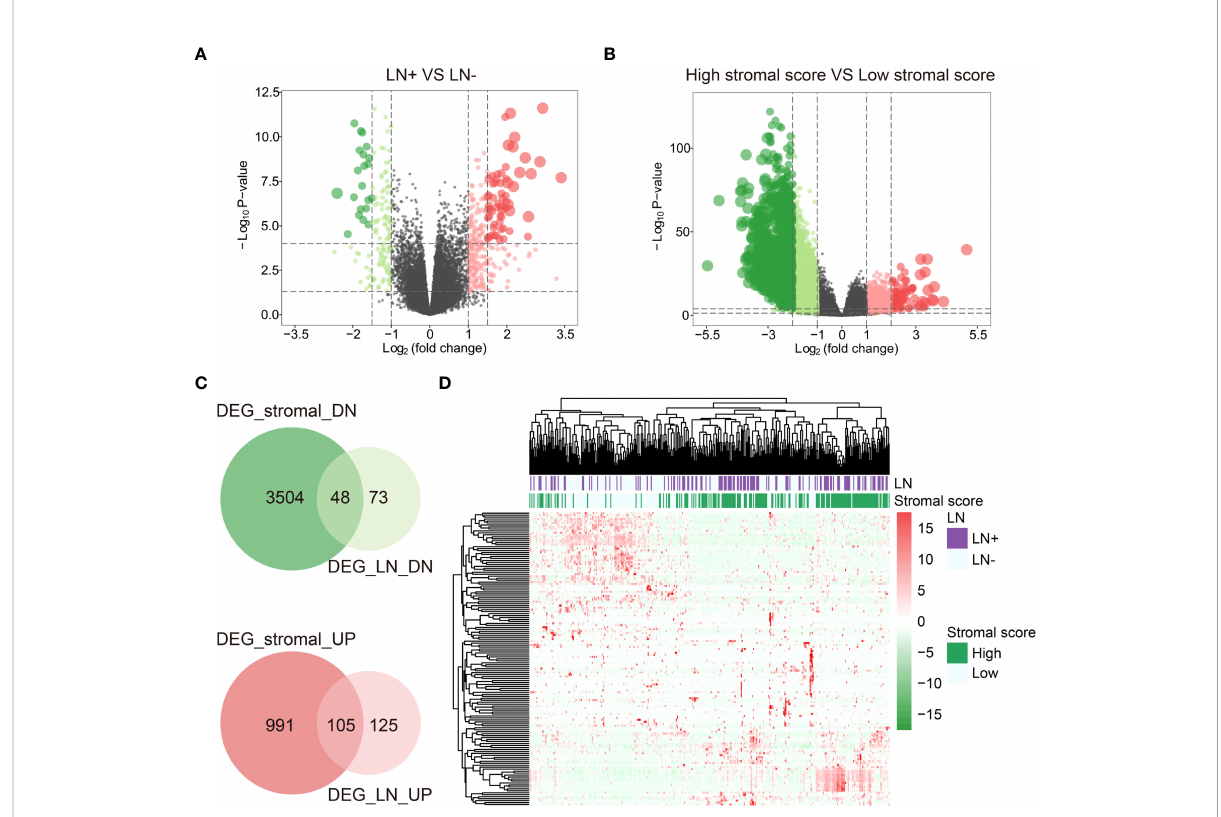
FIGURE 2 DEGs between LN+/- and high/low Stromal score patients. (A) DEGs between LN+ and LN-. (B) DEGs between high/low Stromal score patients. (C) DEGs both involved in Stromal score and LN. (D) Heatmap of DEGs both involved in Stromal score and